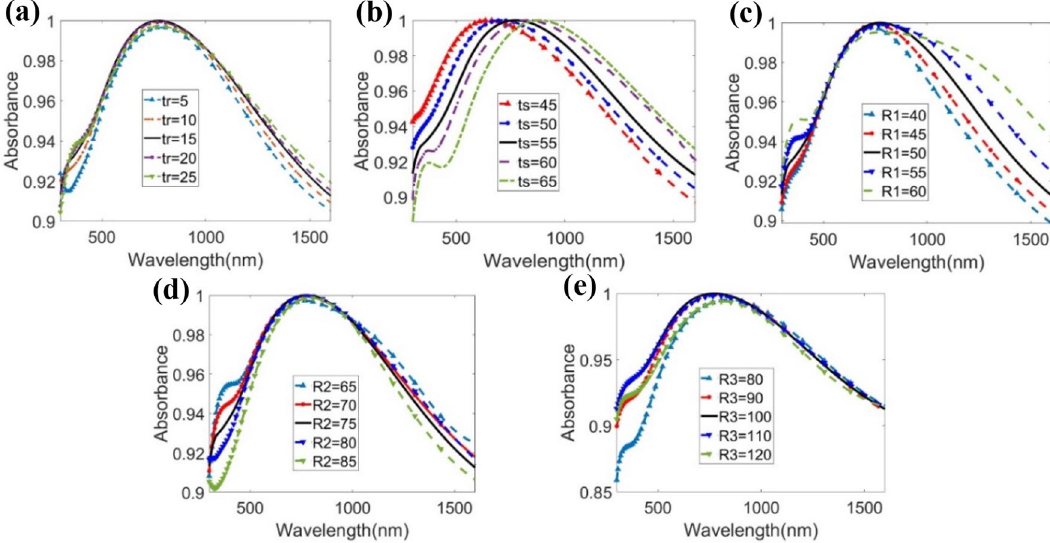
Figure 8. Parametric analysis for parameter ( a ) thickness of the resonator tr, ( b ) substrate thickness ts, ( c ) radius of the central cylinder in resonator R1, ( d ) inner radius of ring shape in resonator R2, ( e ) outer radius of ring shape in resonator R3.